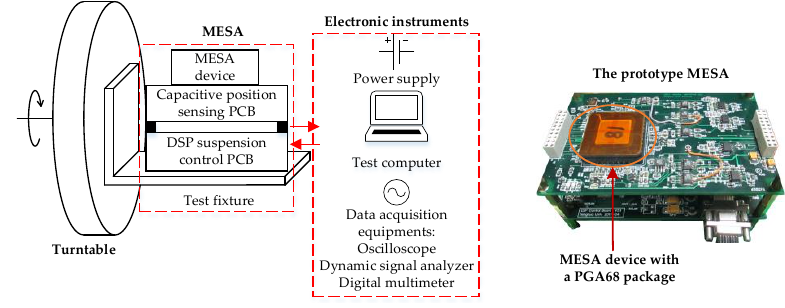
Figure 11. Experimental setup of the prototype MESA.